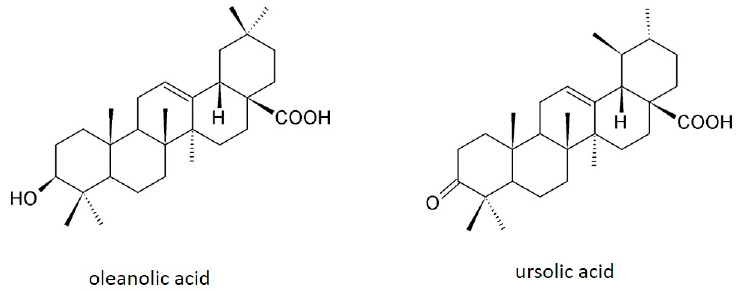
Figure 1. Chemical structures of oleanolic acid and ursolic acid.